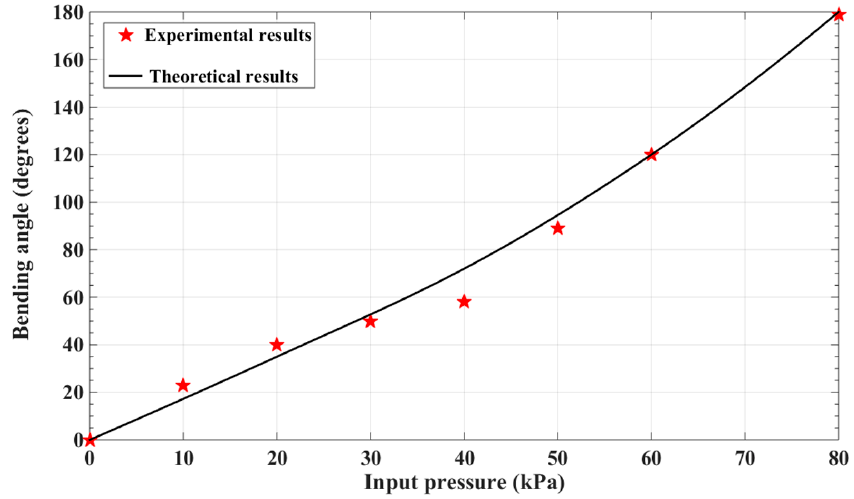
Figure 8. Input pressure against bending angle results of soft actuator.